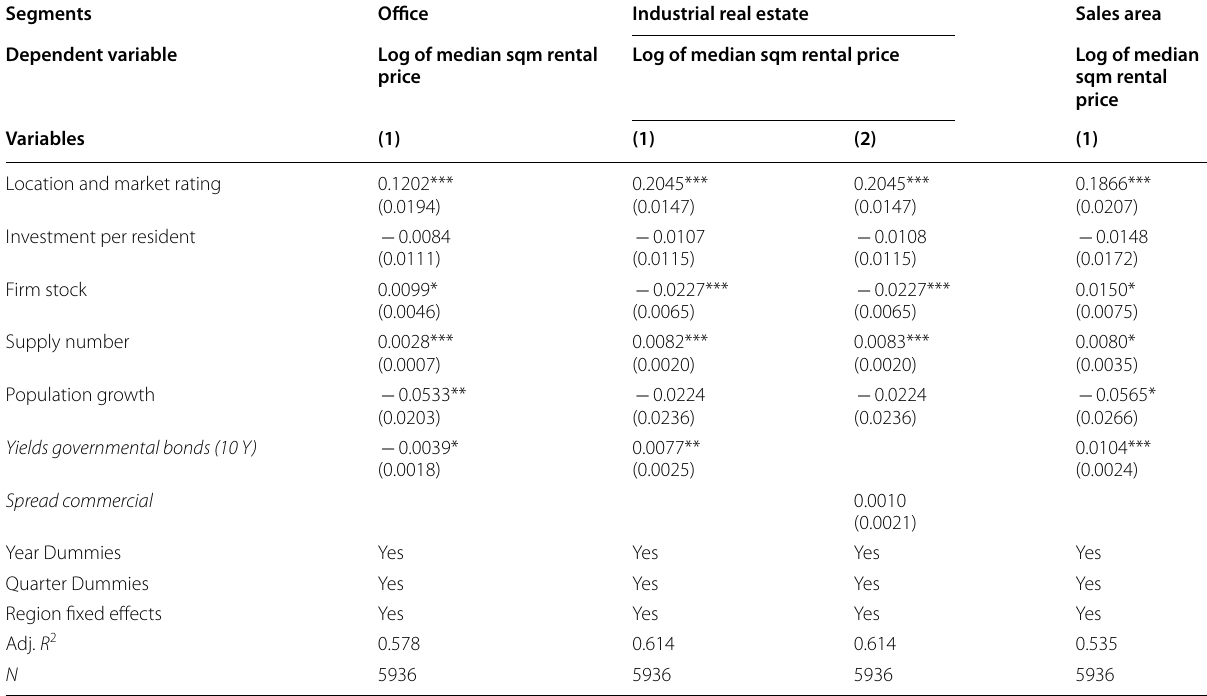
Displayed coefficients are the results of a panel fixed-effect regression model including regional fixed effects for each MS-region. Robust standard errors are displayed in brackets. In models (1) and (2), the time frame was limited to 56 quarters from 2005 Q1 to 2018 Q4. Signif. codes: “***” 0.001, “**” 0.01, “*” 0.05, “.”